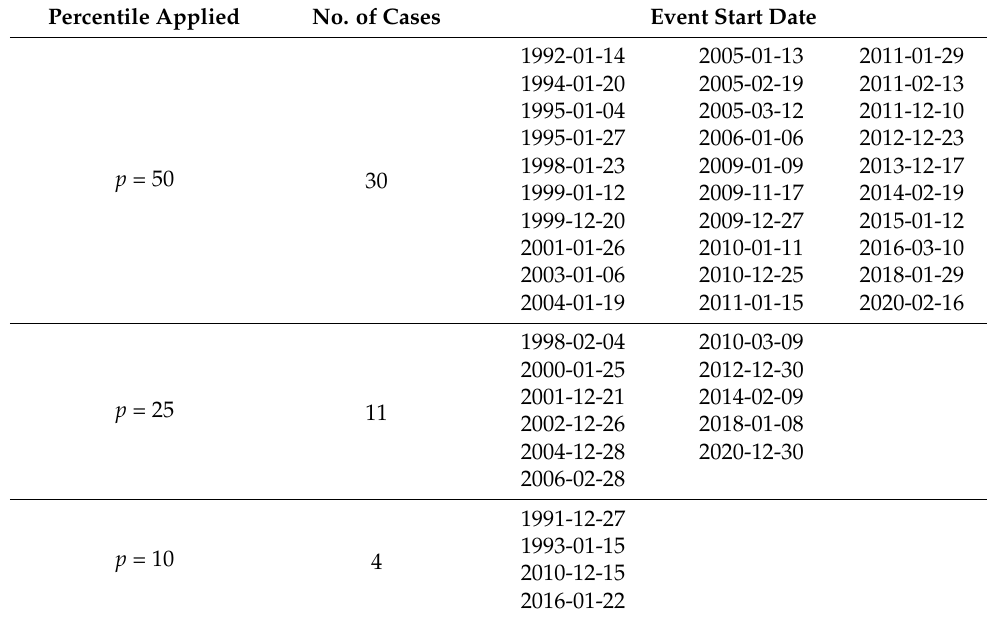
Table 6. List of cold events when different percentile thresholds are applied. An event satisfying thresholds corresponding to a smaller p is not repeated in category(ies) where p is larger.